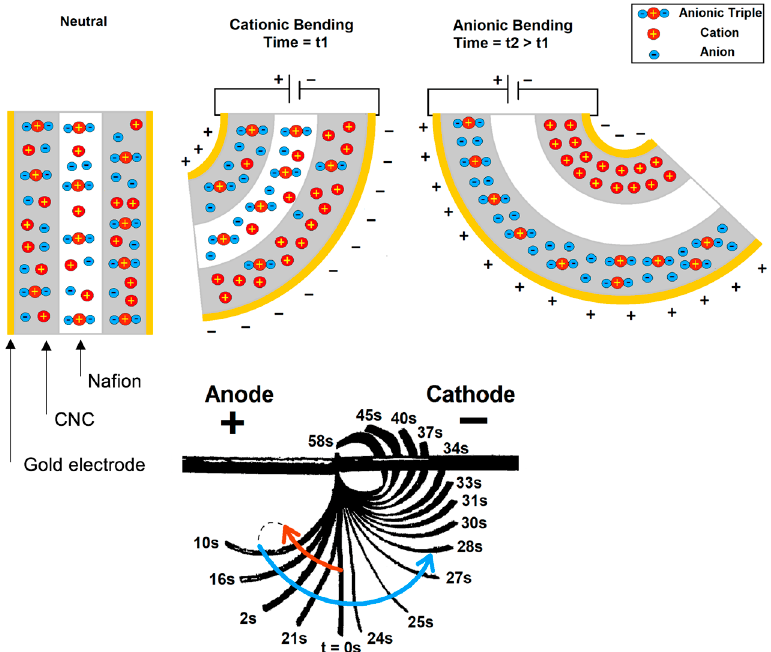
Figure 1 . Idealistic schematic of cationic and anionic bending mechanism (top, not to scale) and overlaid sequential images of cationic (red arrow) bending followed by anionic (blue arrow) bending (bottom)